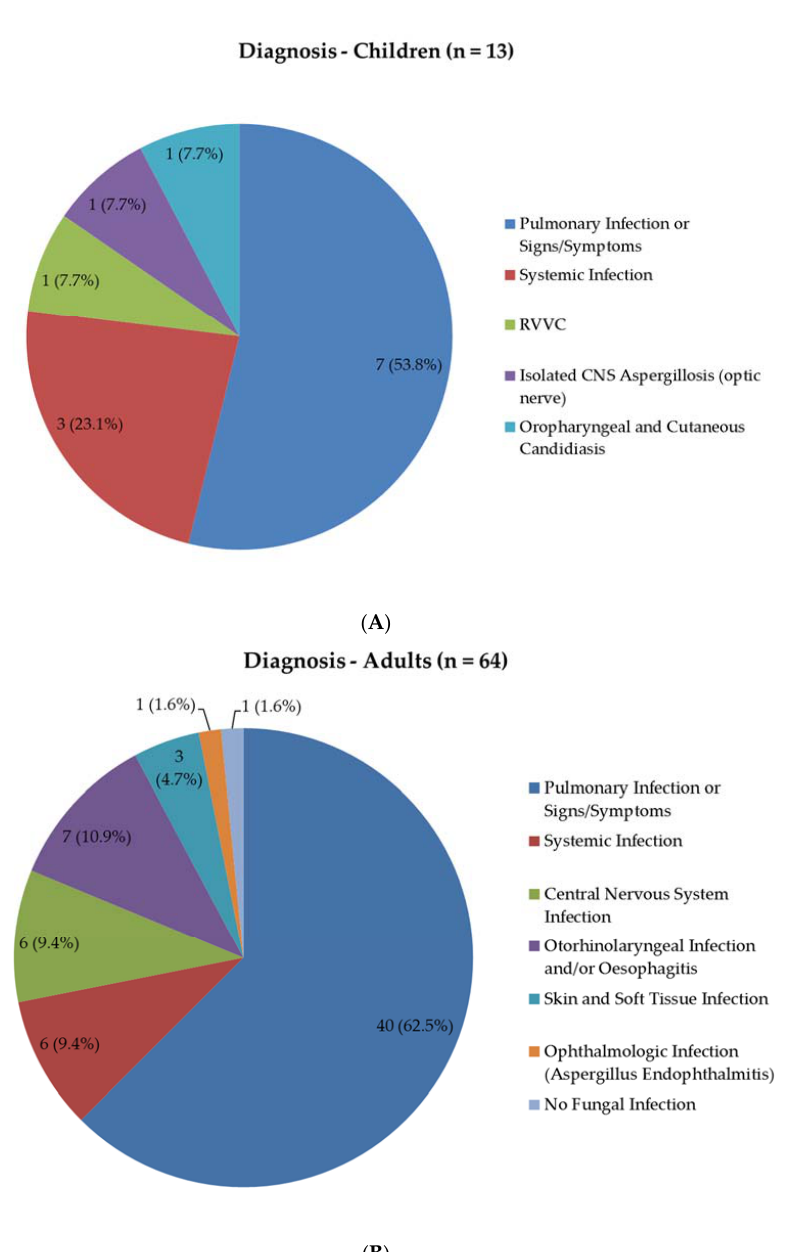
Figure 2. Diagnoses by organ system for paediatric ( A ) and adult ( B ) patients. RVVC, recurrent vulvovaginal candidiasis; CNS, central nervous system.